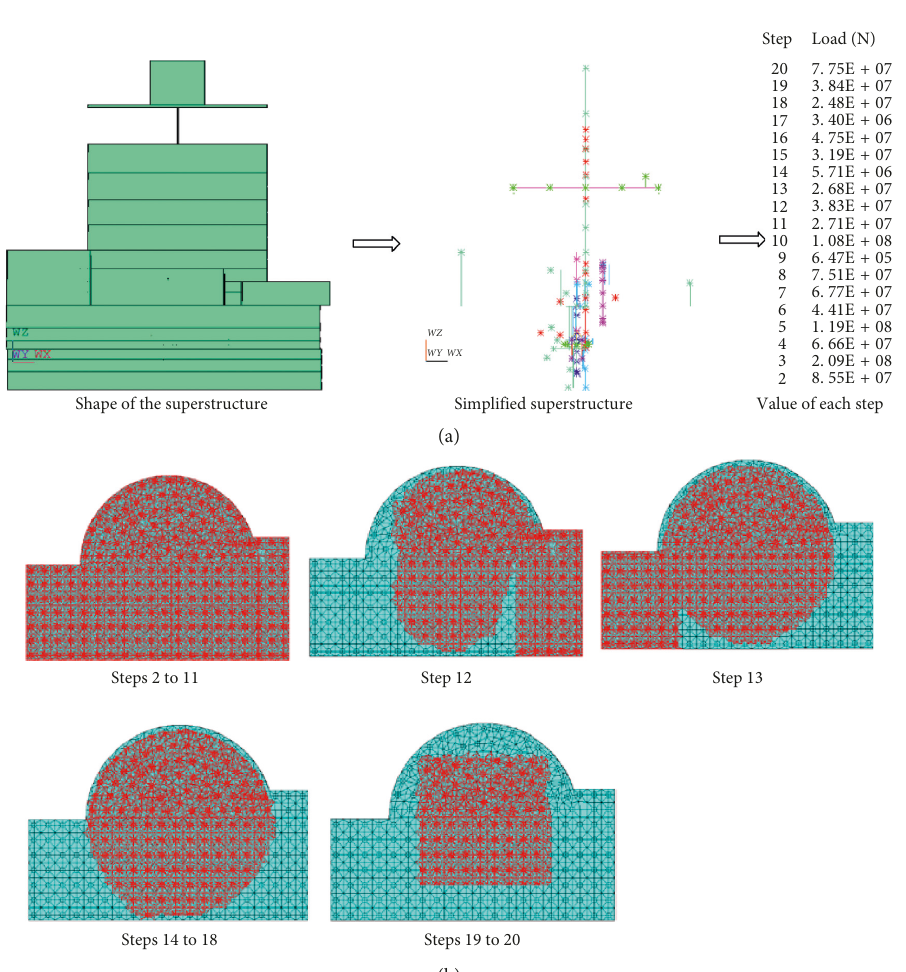
Figure 6: Superstructure of this system and corresponding simplified load: (a) the shape of the superstructure and the value of each load step; (b) the shape of each surface load that acts on the